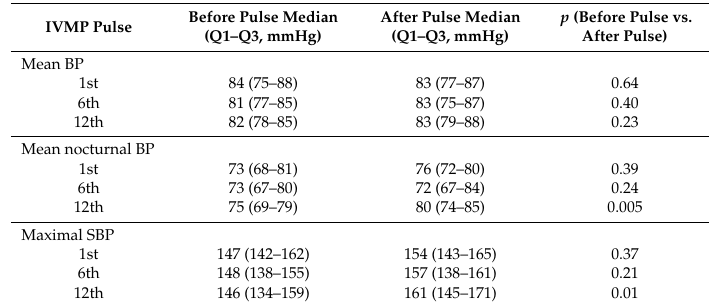
Table 1. Changes in 24-h blood pressure during selected intravenous methylprednisolone (IVMP) pulses in the entire group of patients (N = 22). IVMP Pulse Before Pulse Median (Q1–Q3, mmHg) After Pulse Median (Q1–Q3, mmHg) p (Before Pulse vs. After